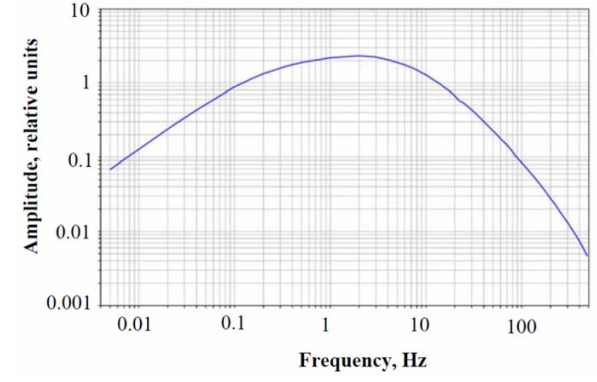
Figure 8. Self-calibration METH W s W f W fb amplitude vs. fre- quency response. Hz on the x axis, relative units on the y